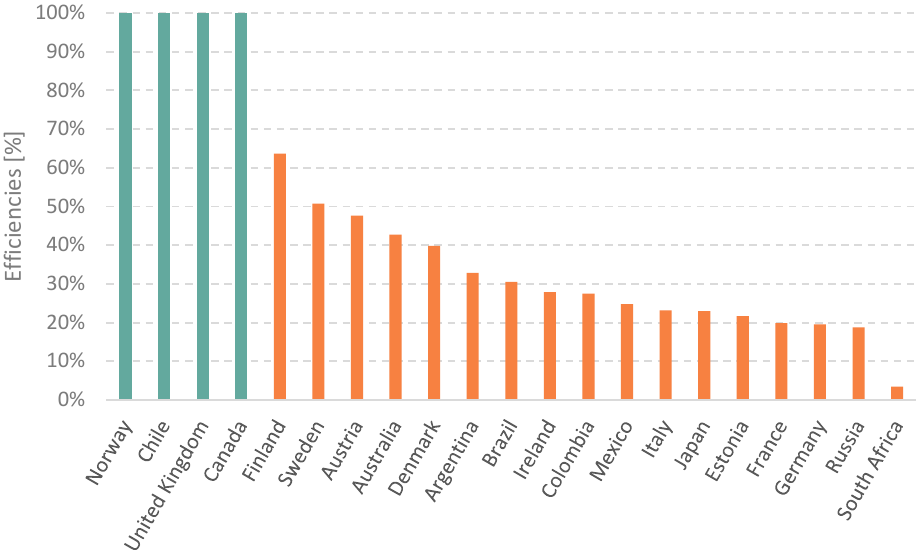
Figure 2. Efficiency ranking—electricity market. Source: The authors. Note: In green: efficient countries; in orange: inefficient countries.